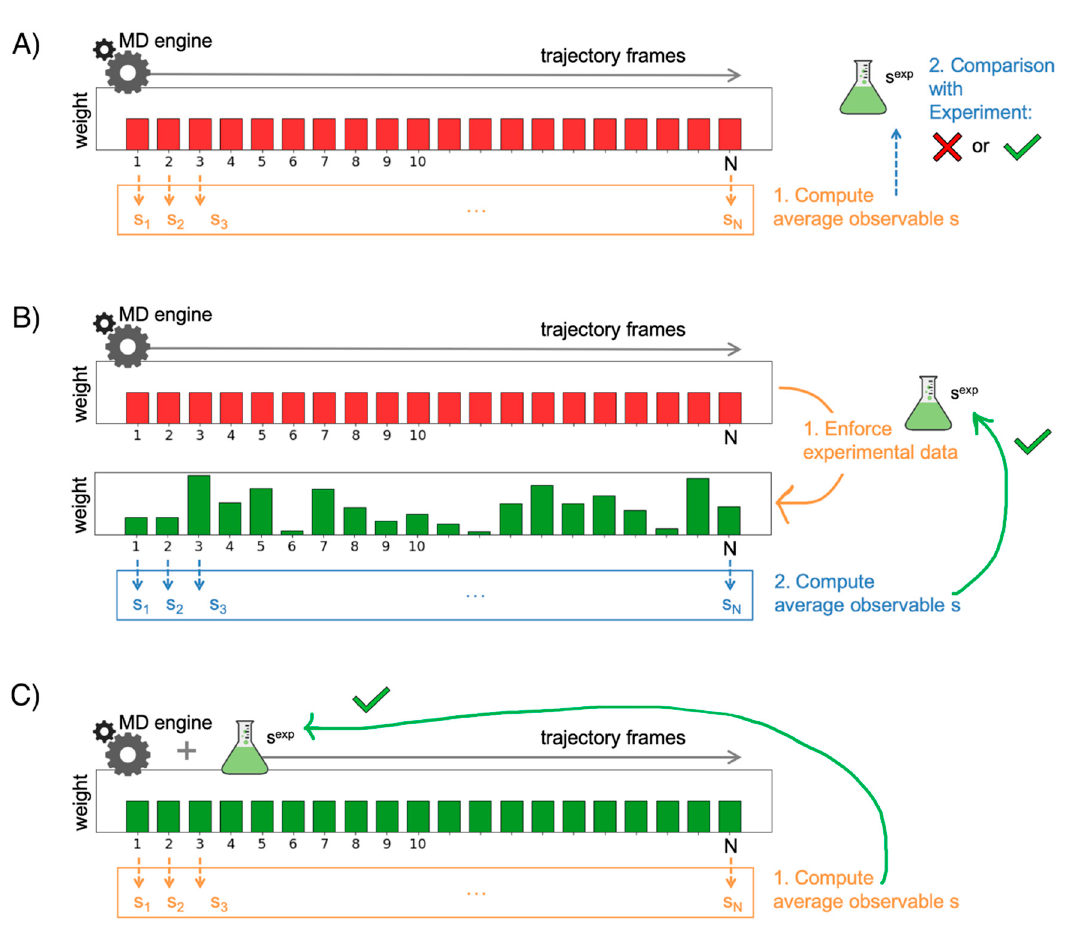
Figure 7. Using MD simulations in combination with experimental information. ( A ) Through a validation procedure, it is possible to estimate the agreement between computed quantities (average observable s, in the figure) and reference experimental data (s exp ). ( B ) Correction of the sampled data through a reweighting procedure can improve the agreement between predicted (MD trajectory) and measured (experiments). ( C ) Enforcing the experimental information in an on-the-fly fashion, the sampled ensemble is restrained to best match the experimental one.